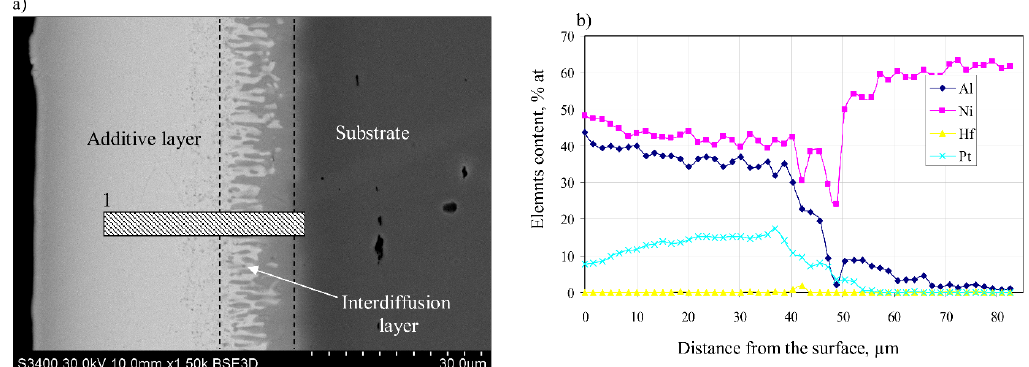
Figure 1. The microstructure of hafnium and platinum-modified aluminide coating deposited by the chemical vapor deposition (CVD) method on the Inconel 625 alloy (striped bar presents an area from which a thin foil for transmission electron microscope (TEM) observations was cut-out) ( a ); and the elements’ content on the cross-section of coating ( b